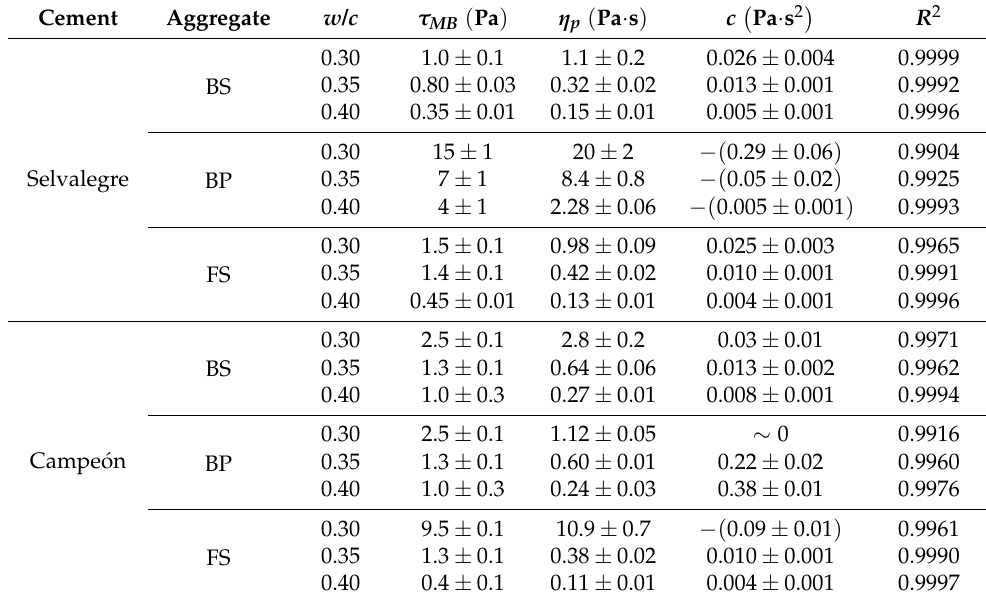
Table 10. Parameters of the modified Bingham equation.